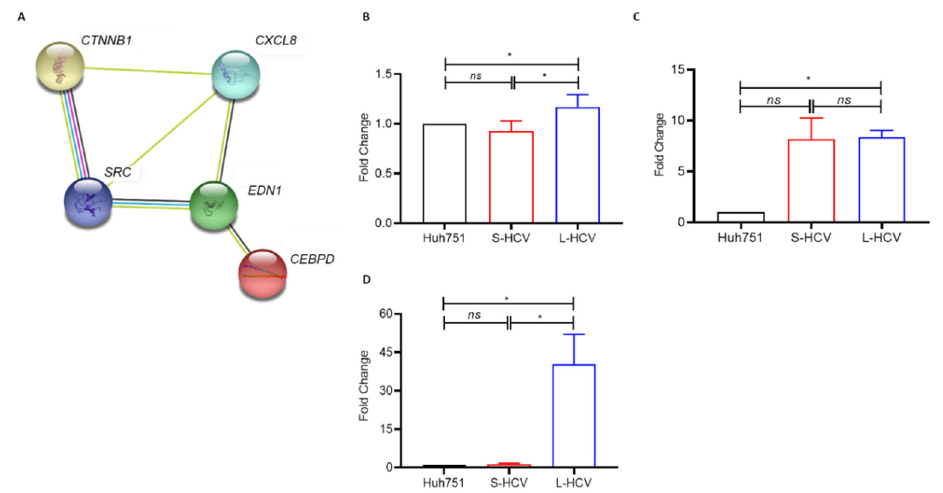
Figure 5. Kaohsiung Medical University Chung-Ho Memorial Hospital (KMUH) hepatitis C virus (HCV)-hepatocellular carcinoma (HCC) cohort ( n = 196). ( A ) CXCL8 level in non-HCC and HCC patients. ( B ) CXCL8 level in non-HCC patients with SVR and non-SVR compared to non-HCC pa- tients with SVR and non-SVR. Statistical significance p < 0.05 *, p < 0.001 ** ** while values p > 0.05 were deemed non-significant (ns).